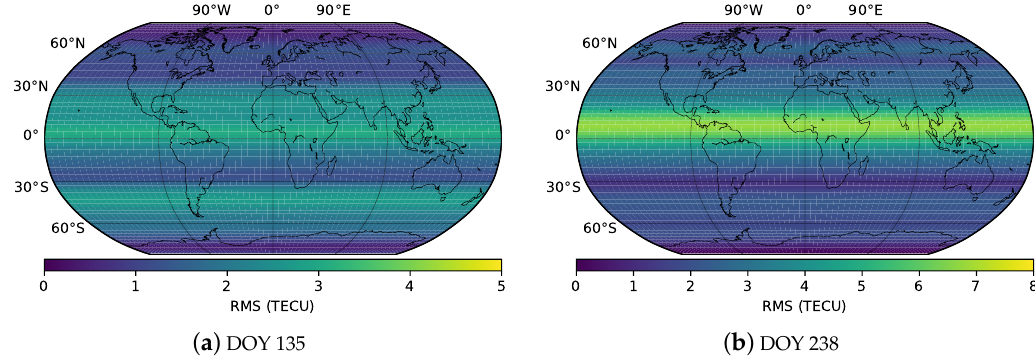
Figure 13. RMS values of different latitudes at 12:00 UT on DOY 135 ( a ) and DOY 238 ( b ), 2018.